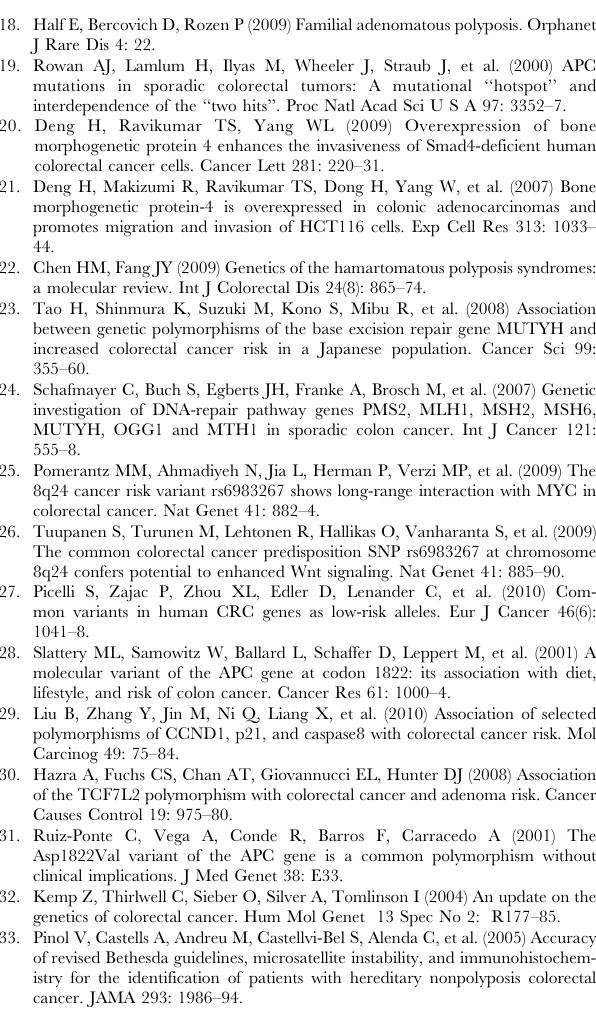
Figure S2 Principal component analysis plot for the first vs. second component, comparing our case and control populations.